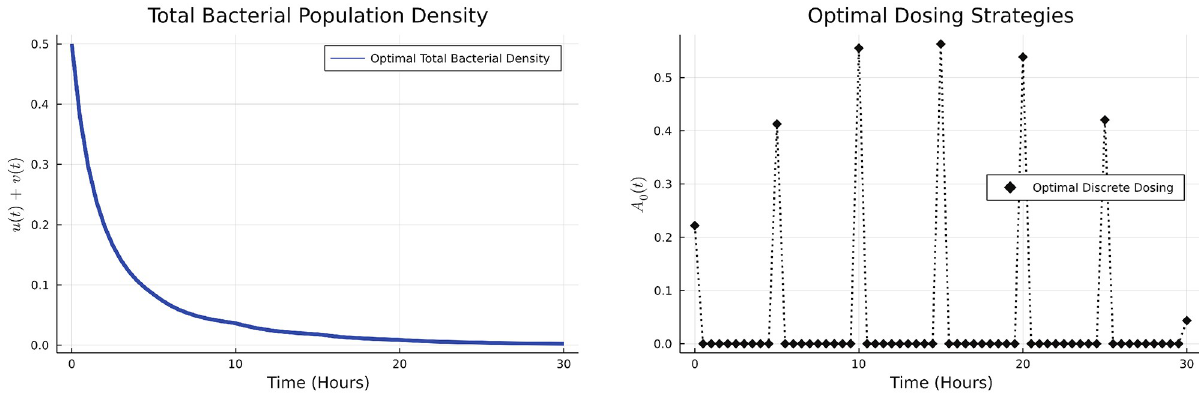
Fig 7. Optimal dosing strategy and bacterial population.